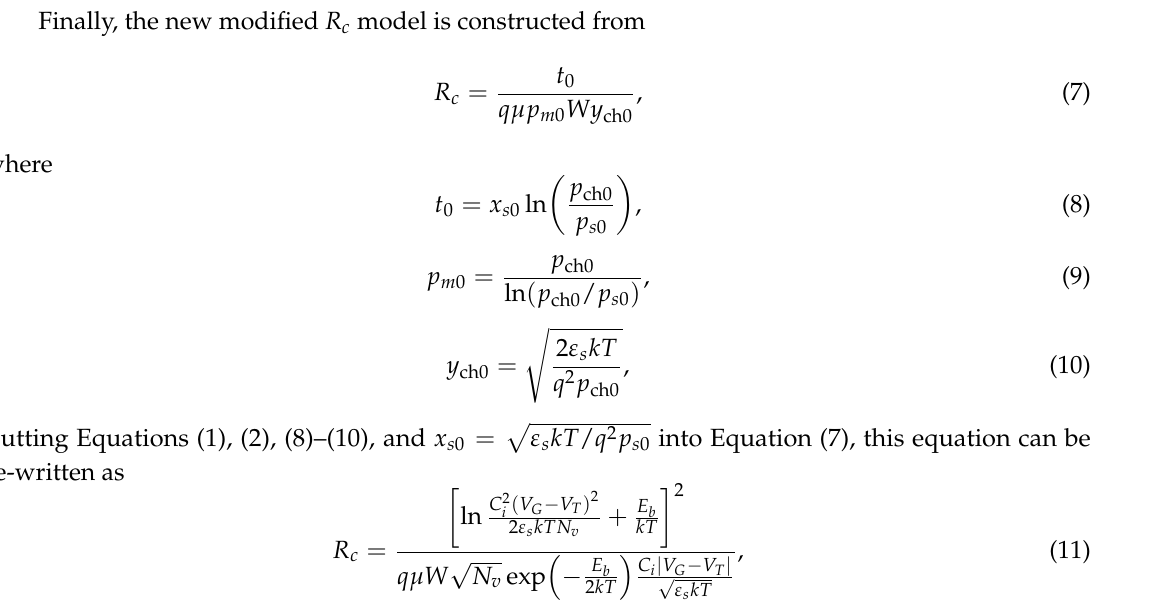
Figure 2. Calculation results showing the film-thickness-direction variations of p m (blue triangles) and R num (red circles) under a fixed set of parameters. These fixed parameters are written on the graph ( T = 300 K).